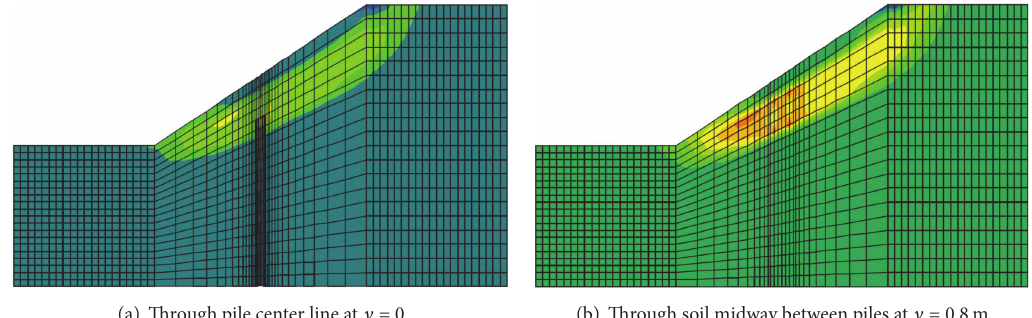
Figure 17: Failure mode of a slope with piles C = 0.71 at different sections.